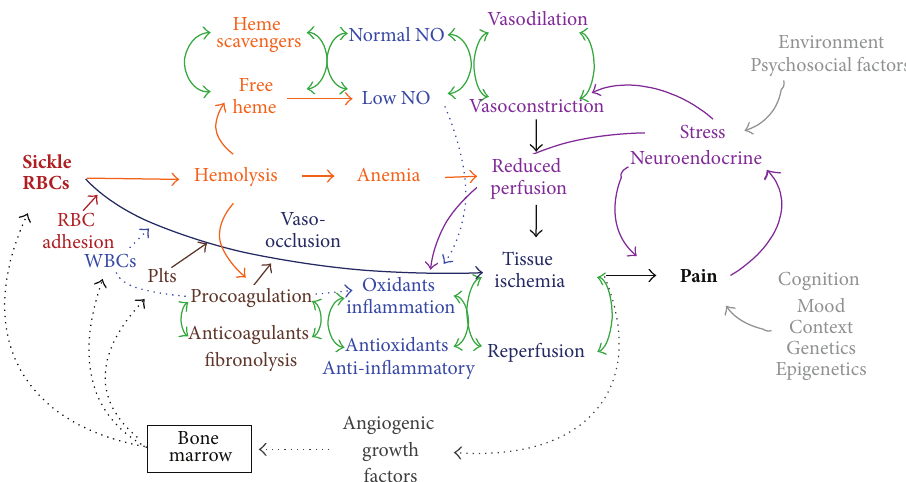
Figure 1: Acute pain model. This diagram shows proposed interactions between pathophysiologic mechanisms in sickle cell disease that lead to acute painful episodes. Key to mechanisms: green: balancing feedback loops, red: erythrocytes, orange: hemolysis, light blue: inflammation and oxidant stress, dark blue: ischemia and reperfusion, lavender: vasomotor, brown: coagulation, gray: angiogenesis, and light gray: pain modifiers. See text for details.